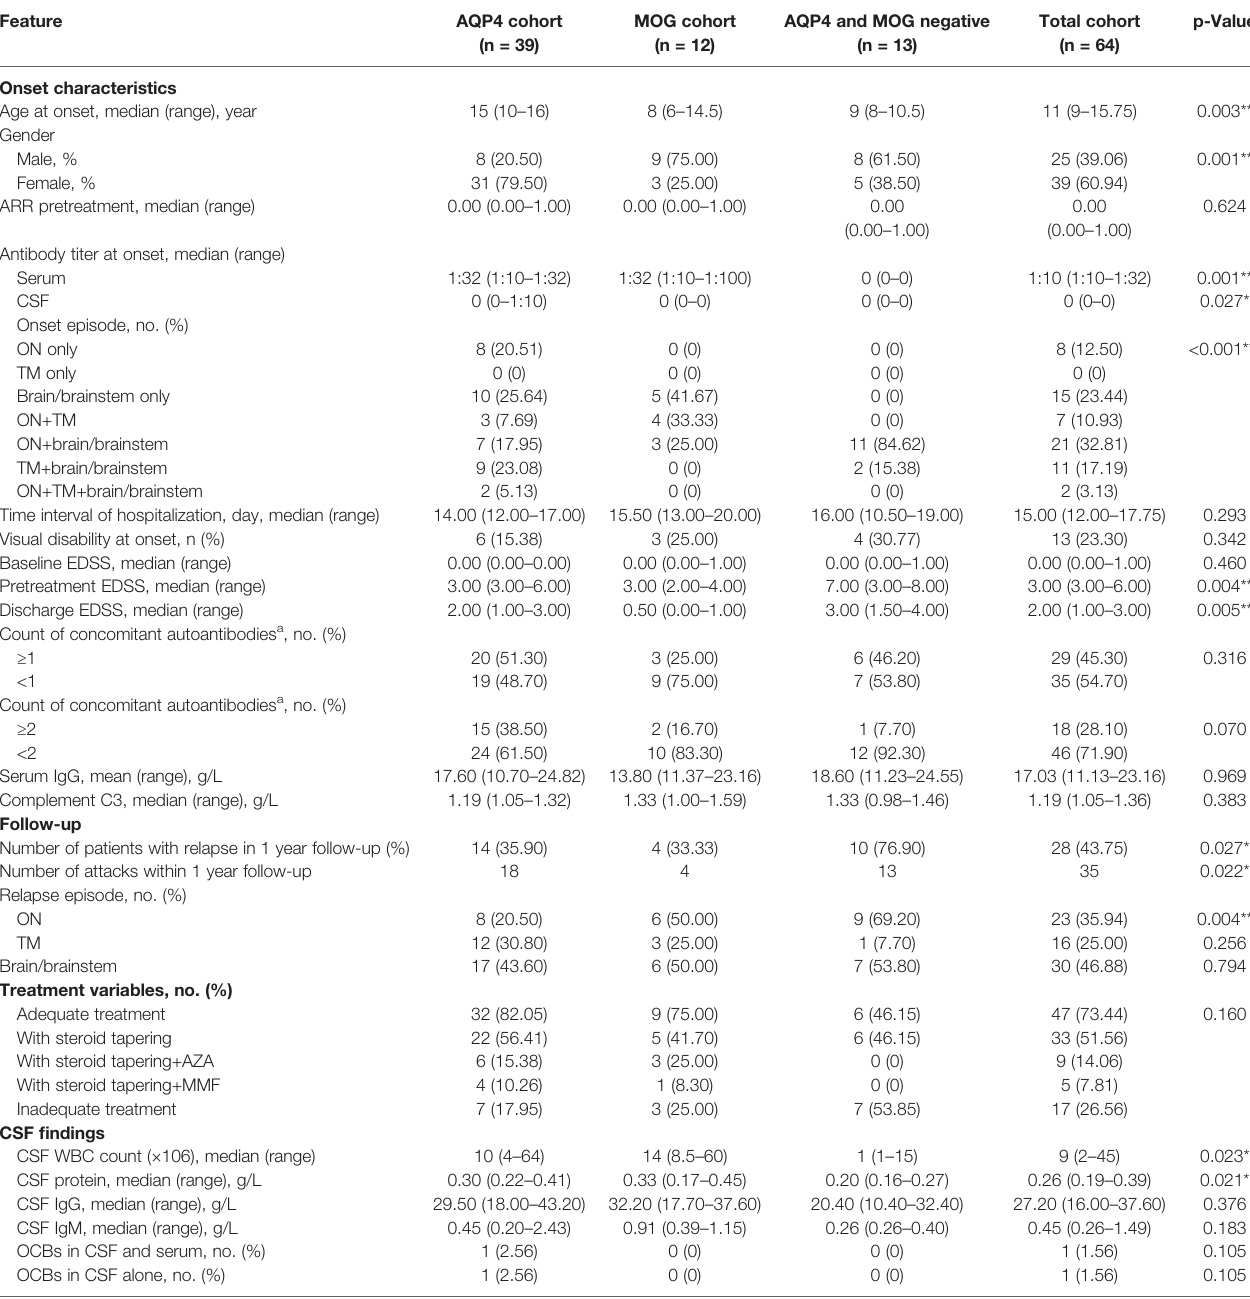
TABLE 1 | The demographics and clinical characteristics of pediatric NMOSD patients with positive AQP4 antibody, positive MOG antibody, and double-antibody negative. Feature AQP4 cohort